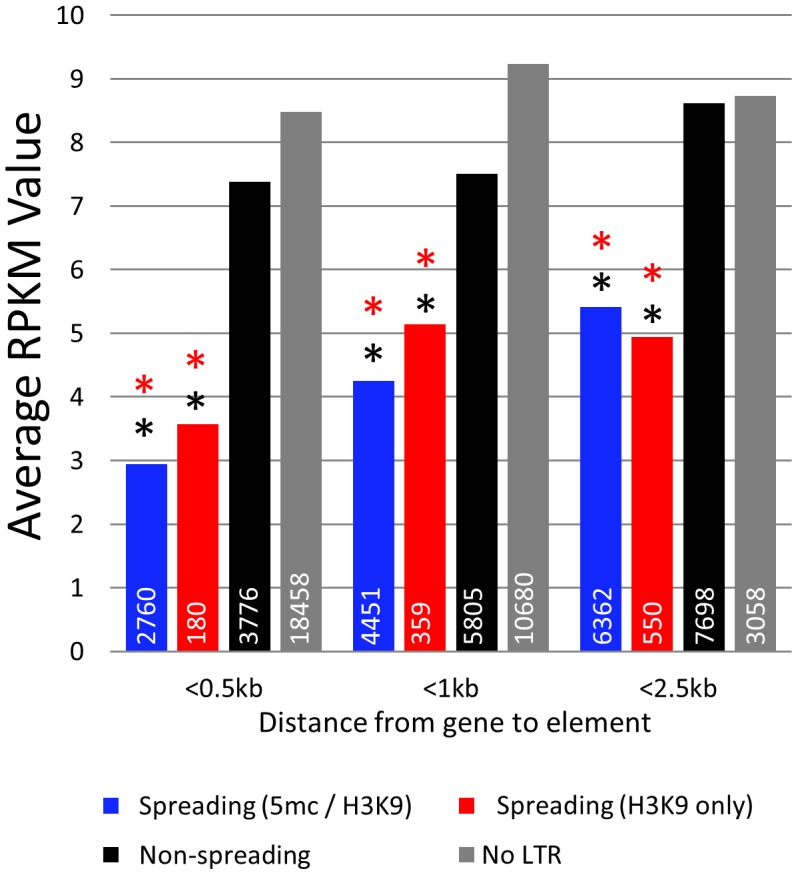
Genes near spreading retrotransposons show lower expression than genes near non-spreading retrotransposons.Average RPKM values (from B73 leaf) for all genes falling within 0.5 kb, 1 kb, and 2.5 kb from the respective class of retrotransposons were developed. White numbers within bars indicate the total number of genes within each category. Red asterisks indicate highly significant (p<0.001) difference from the non-spreading retrotransposons (black) within the distance classification. Black asterisks indicate significant (p<0.001) difference from genes not near any retrotransposons (grey).